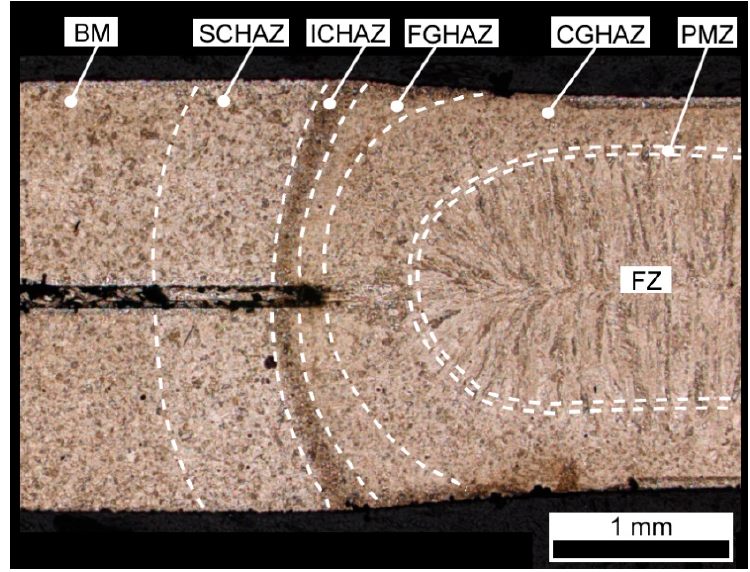
Figure 7. Macrostructure region of the specimen in the two-step RSW.